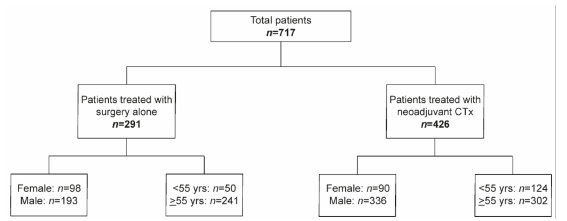
Figure 1. Overview of the